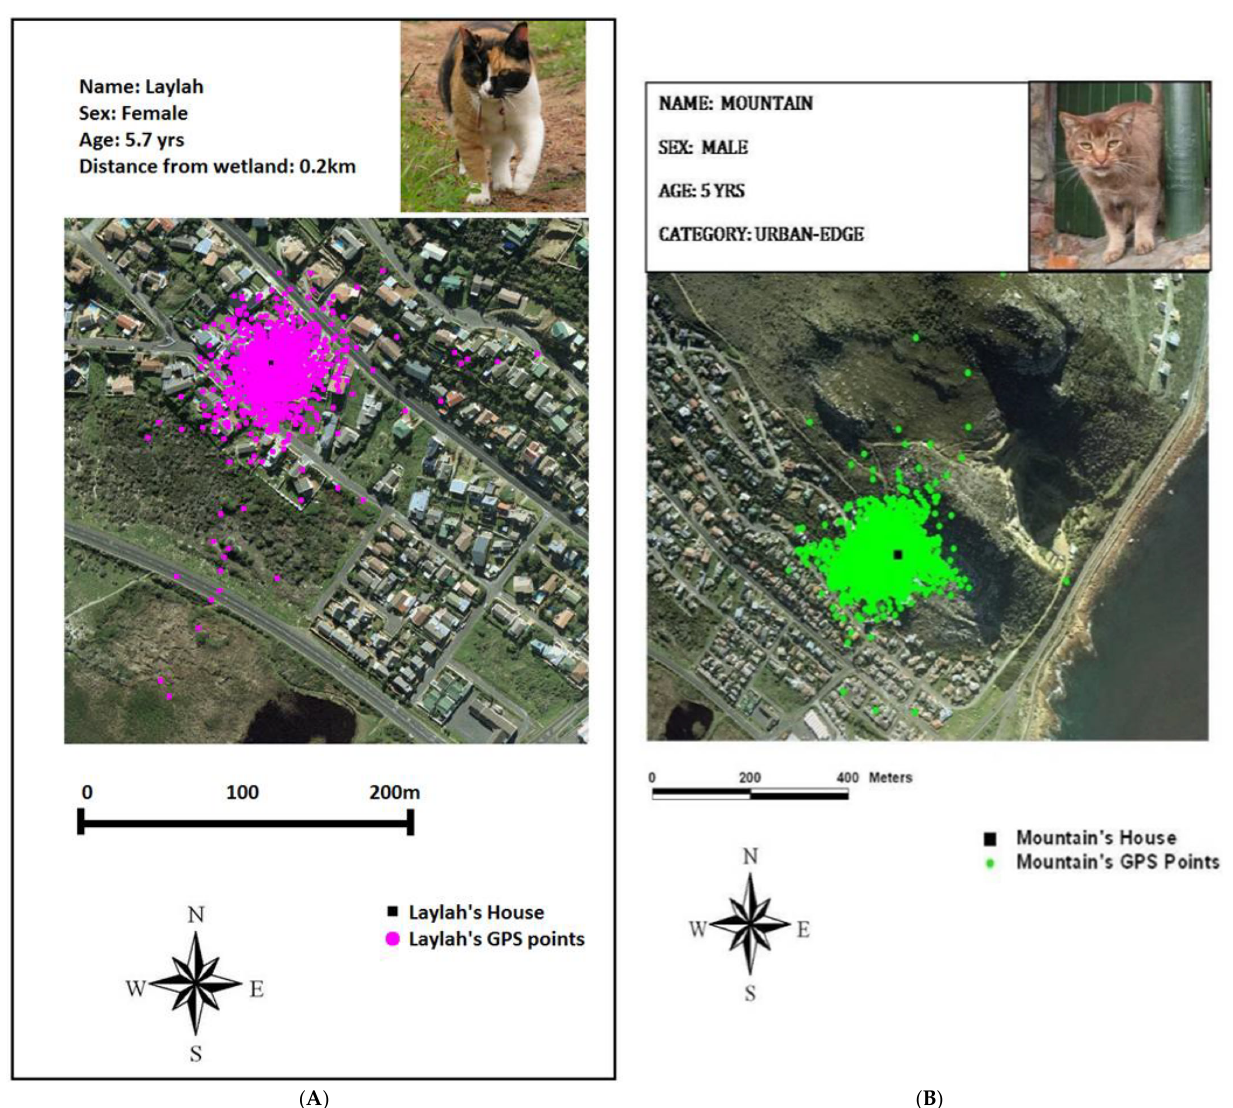
Figure 2. An example of the larger summer (7-day) home ranges of cats compared to winter ranges for UE cats adjacent to the same urban natural areas (Glencairn wetland and TMNP). The winter track ( A ) of Laylah, a female housed close to the wetland, with a 95% kernel range of 1.03 ha and the largest displacement of any cat in winter of 298 m. The summer track of Mountain ( B ), with a home range more than twice the size at 2.71 ha and maximum displacement about twice that of Laylah (of 567 m). Note the difference in scales.